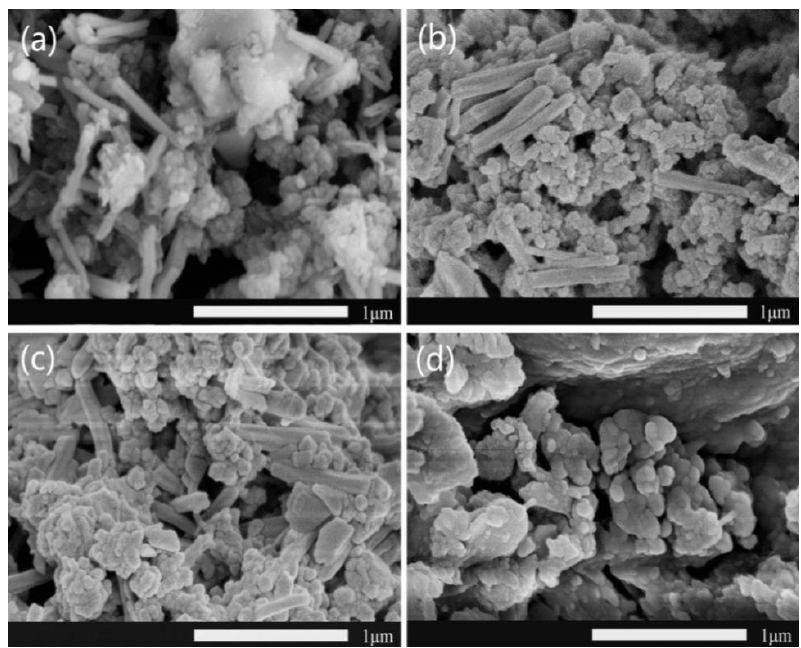
Figure 6. SEM images of the WPPy/cement composites with different curing ages. 1 day ( a ), 3 days ( b ), 7 days ( c ), 28 days ( d ).